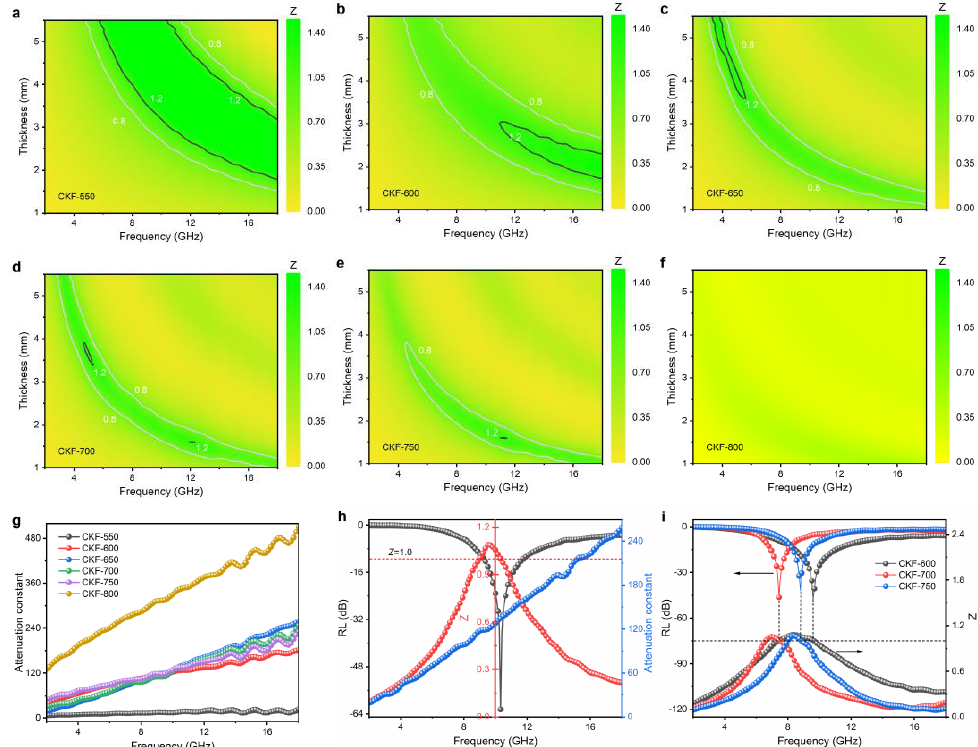
Figure 7. ( a – f ) Contour maps of Z values for CKF-based absorbers as a function of thickness and frequency; ( g ) calculated attenuation constant of prepared CKF samples; ( h ) the relationship between RL, attenuation constant, and Z for CKF-650; ( i ) frequency-dependent RL and Z for CKF-600, CKF 700, and